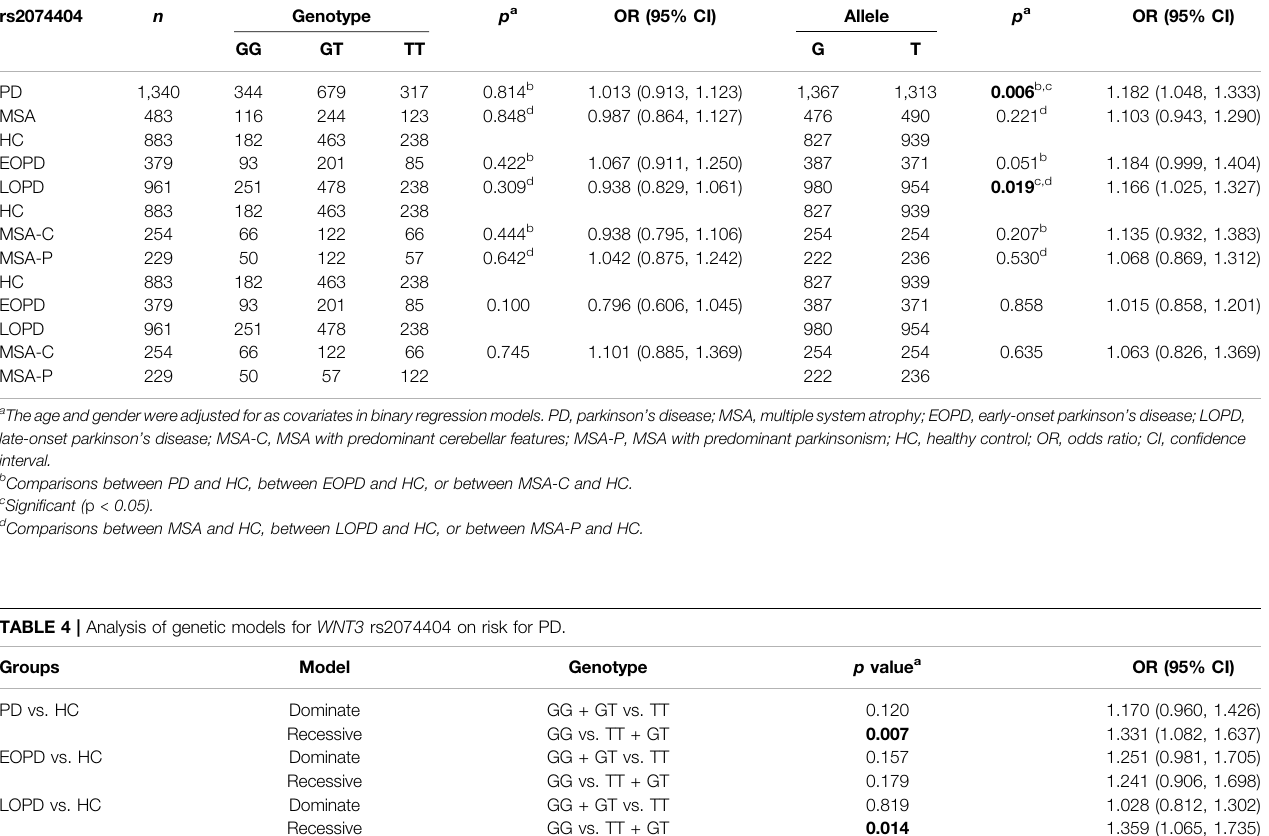
TABLE 3 | Distributions of genotype and allele frequencies of WNT3 rs2074404 observed in PD, MSA and healthy-matched control. rs2074404